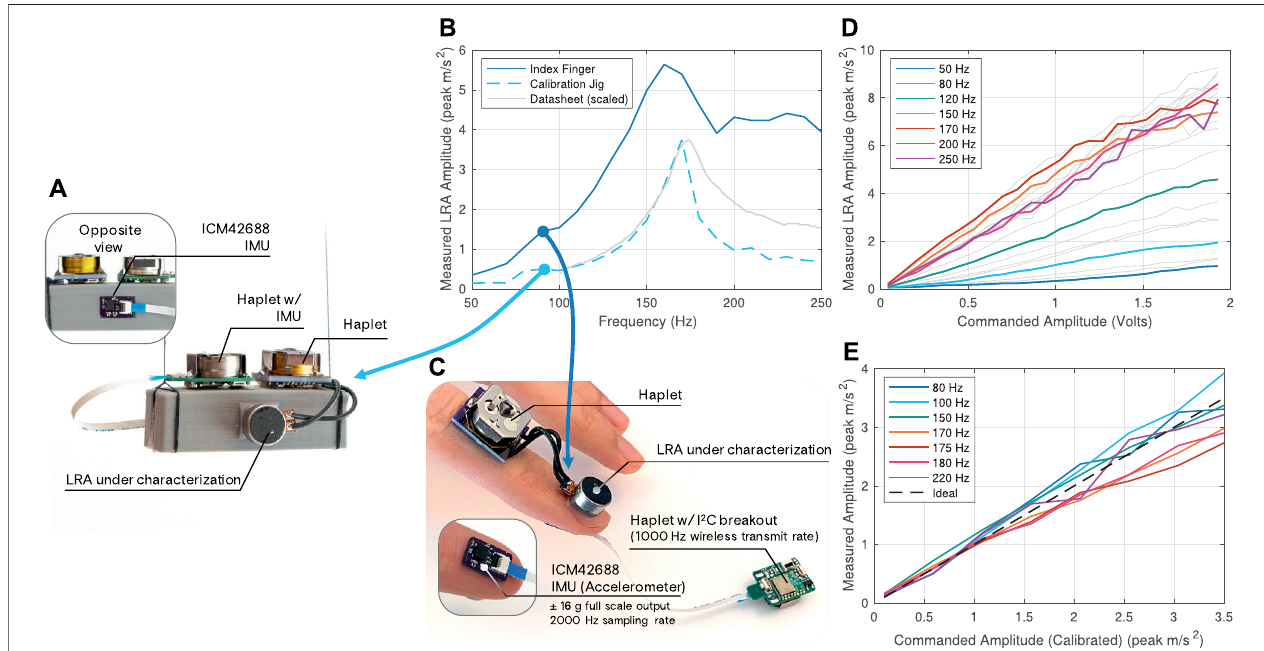
FIGURE 3 | Haplets under characterization are shown and their resulting plots. (A) The characterization jig used for characterizing a Haplet ’ s LRA. The jig is hung using two threads from a solid foundation. A special Haplet with an IMU is used to record the accelerations resulting from the LRA ’ s inputs. (B) The characterization results fromthejigcloselyresembles thecharacterization derivedfromtheLRA ’ sdatasheet, however,thecharacterizationresultswhen theLRAisplacedona fi ngernail is substantially different. (C) The same devices used in the characterization jig are placed on the fi ngernail and fi ngerpads to perform LRA characterization at the fi ngertips. (D) Results from characterization at the fi ngertip at various frequencies. (E) After compensating for reduced amplitude outputs using the model derived from characterization, commanded amplitudes, now in m/s 2 , closely match the output amplitude.